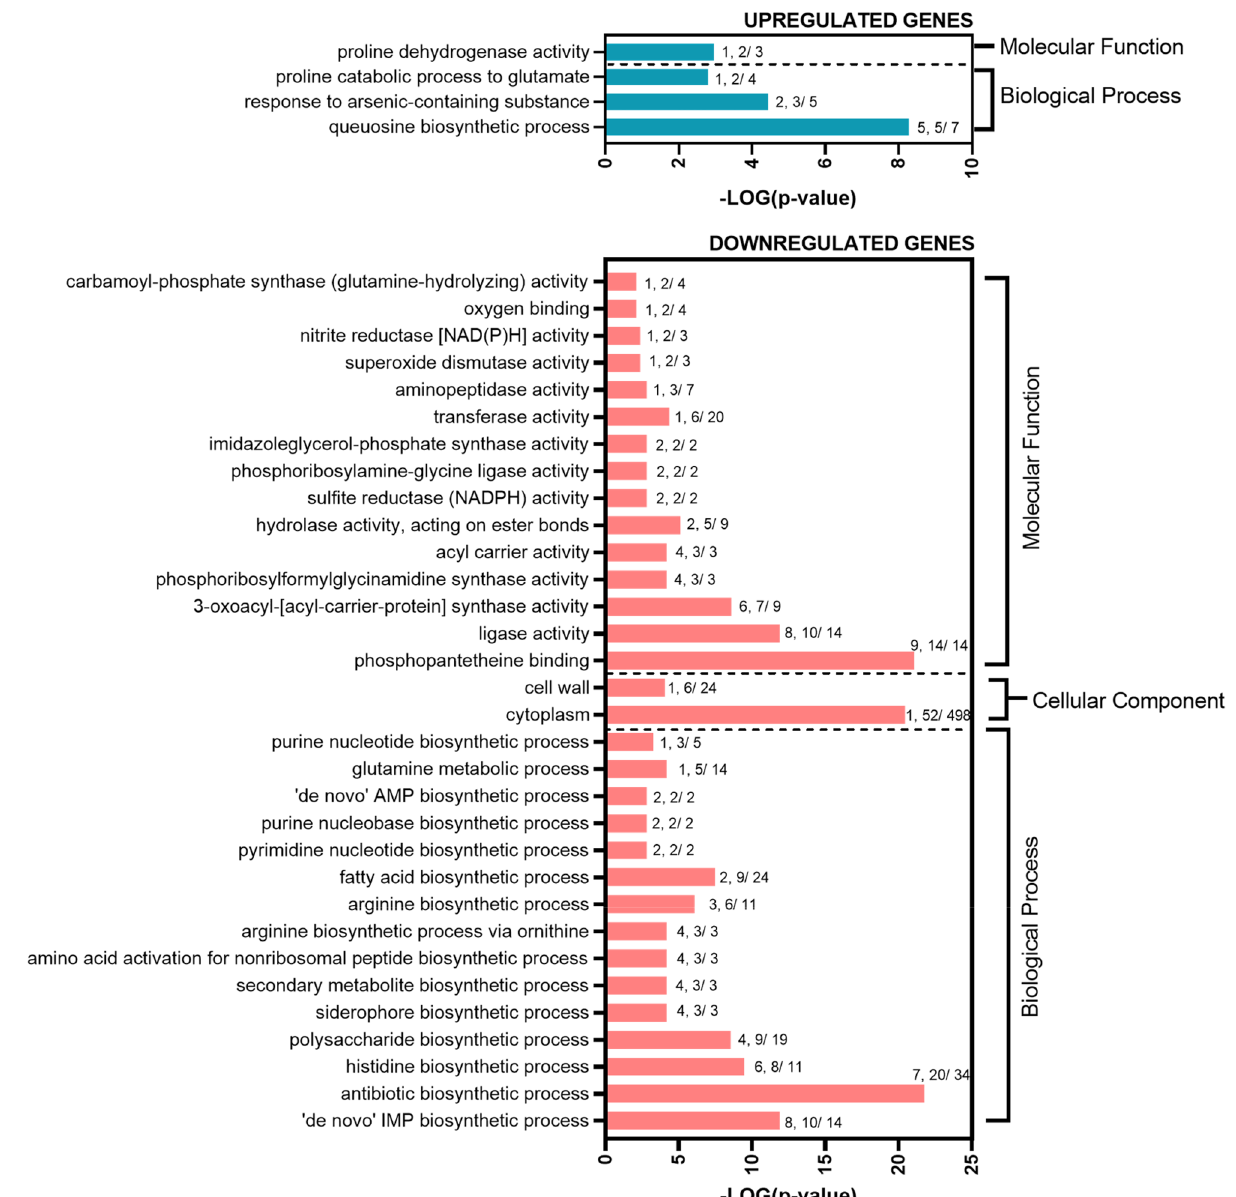
Figure 2. GO terms significantly affected in B. subtilis VBNC cells. A graphical representation of DEGs ( p value ≤ 0.05 and a log 2 FC ≥ 3) annotated by GO analysis in GSEA-Pro3. The values given to each bar correspond to Score (0–9, 0 being not significant, ranked based on Benjamini–Hochberg Algorithm) and the hits/class